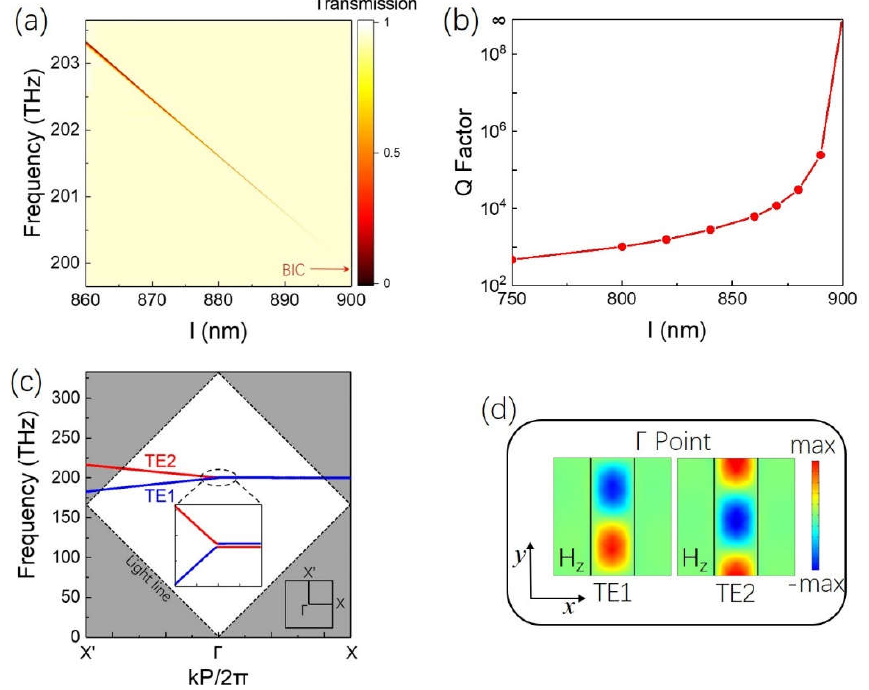
Figure 2. ( a ) Map of transmission spectra for 2D RMS by sweeping length l 1 from 860 to 900 nm, where width w 1 (335 nm) and height h 1 (200 nm) were kept constant. ( b ) Q factor with respect to length l 1 . ( c ) Numerically simulated band structure. The bands under consideration were above the light cone. The lower right inset shows the first Brillouin zone; the middle inset is an enlarged view near the Γ point. ( d ) Magnetic field distribution of TE1 and TE2 at Γ